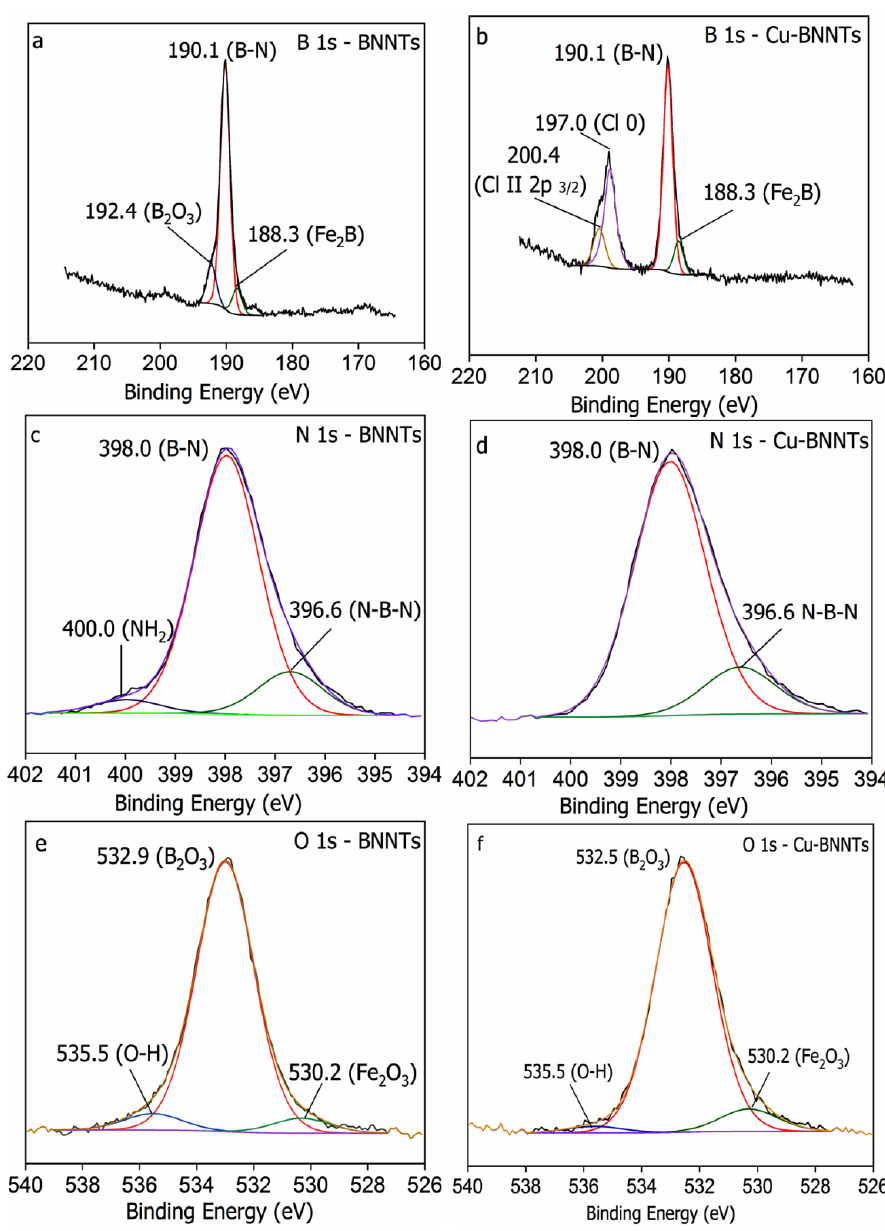
Figure 5. B 1s, N 1s and O 1s high-resolution XPS spectra for ( a , c , e ) BNNTs, ( b , d , f ) Cu-BNNTs. Figure 6 depicts the high-resolution spectrum XPS for Cu-BNNTs. The dominant Cu 2p 3/2 peaks at 933.8 and Cu 2p 1/2 at 953.6 eV, which demonstrate the successful reduction of CuCl 2 , can be assigned to metallic Cu(0), whereas the small peak at 936.2 eV can be assigned to Cu(II). Meanwhile, the peaks of Cu 2p 1/2 at 955.9 eV, in combination with the satellite peak at 944.3 eV, are typical characteristics of CuO, implying the uniform surface oxidation of Cu nanoclusters that were exposed to air under ambient conditions [34,35]. Cu(0) and Cu(I) are hard to differentiate since they have a ~0.3 eV separation in binding energy, whereas Cu(0) and Cu(II) have more than a 2eV separation. The Cu 2p 5/2 peak around 958.1 eV indicates a Cu(II) oxidation state [36,37].